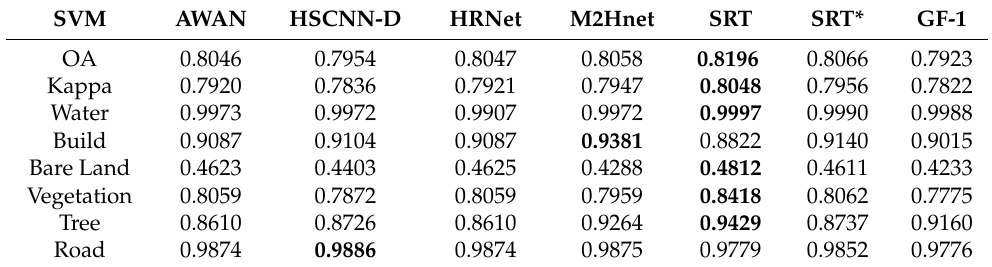
Table 8. Accuracy of classification result of Area2 with SAM. The best results are shown in bold.